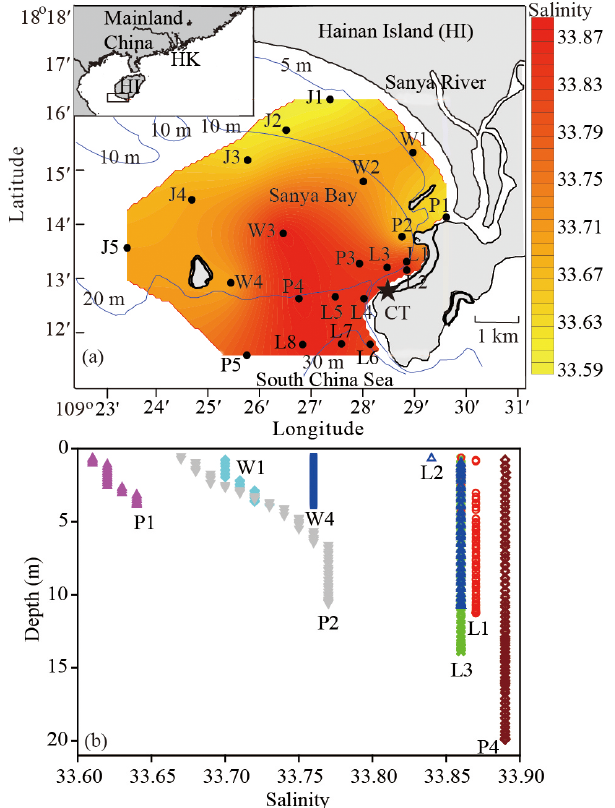
Figure 1. Study area, sampling stations and salinity distribution (a) and vertical profiles of salinity (b) in February 2012 in Sanya Bay, Hainan Island (HI) in the South China Sea. HK represents Hong Kong. CT is the coastal reef time-series station. Salinity data were reported in Wang et al.